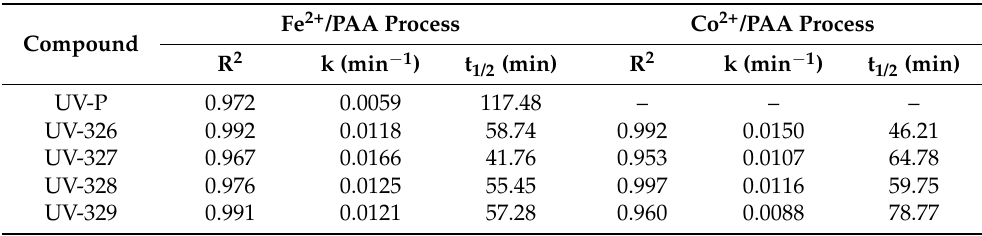
Table 5. Determination coefficients (R 2 ), first-order constant (k), and half-life time (t 1/2 ), of BUVs’s removal by Fe 2+ , for Co 2+ /PAA-based